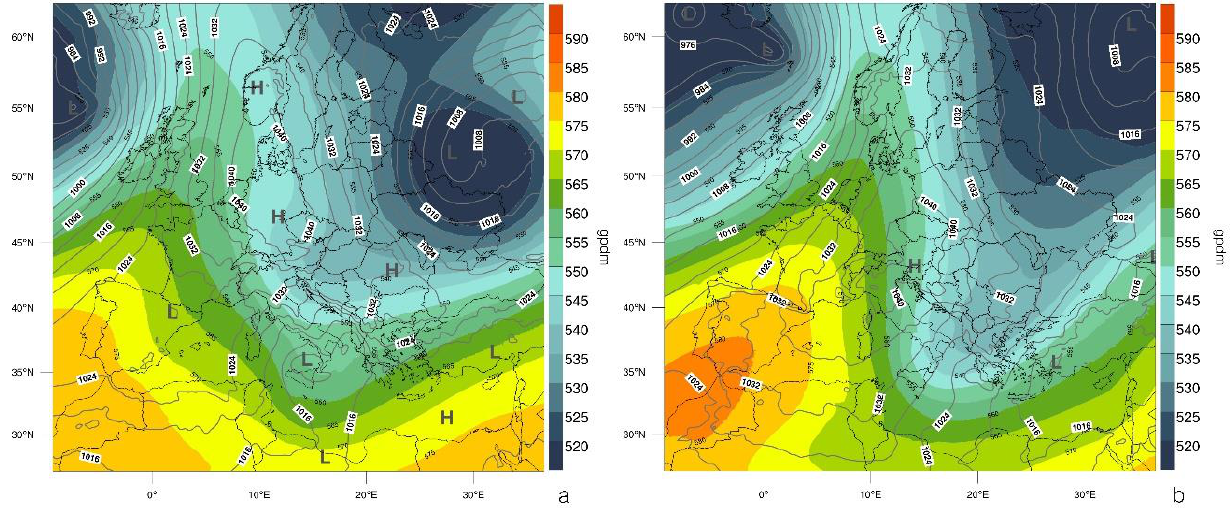
Figure 6. Forecasts of 500 hPa geopotential height (color shade every 5 gpdm) and mean sea-level pressure (grey contours every 4 hPa) valid on: ( a ) 13 February 2021 at 0000 UTC and ( b ) 15 February 0000 UTC based on BOLAM model initialized at 10 February 2021 at 0000 UTC.